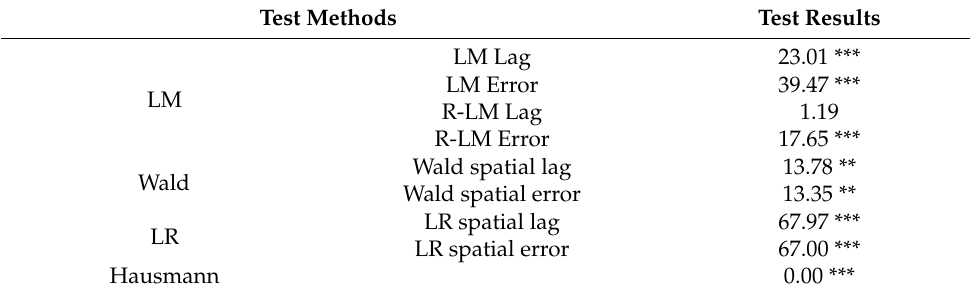
Table 10. Selection and test of spatial econometric model.